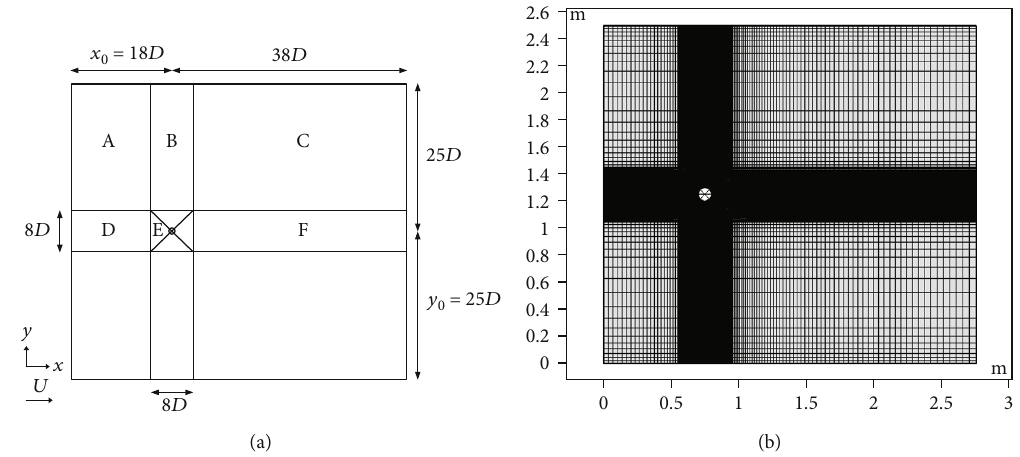
Figure 1: Sketch of (a) the computational domain and (b) element mesh over the entire